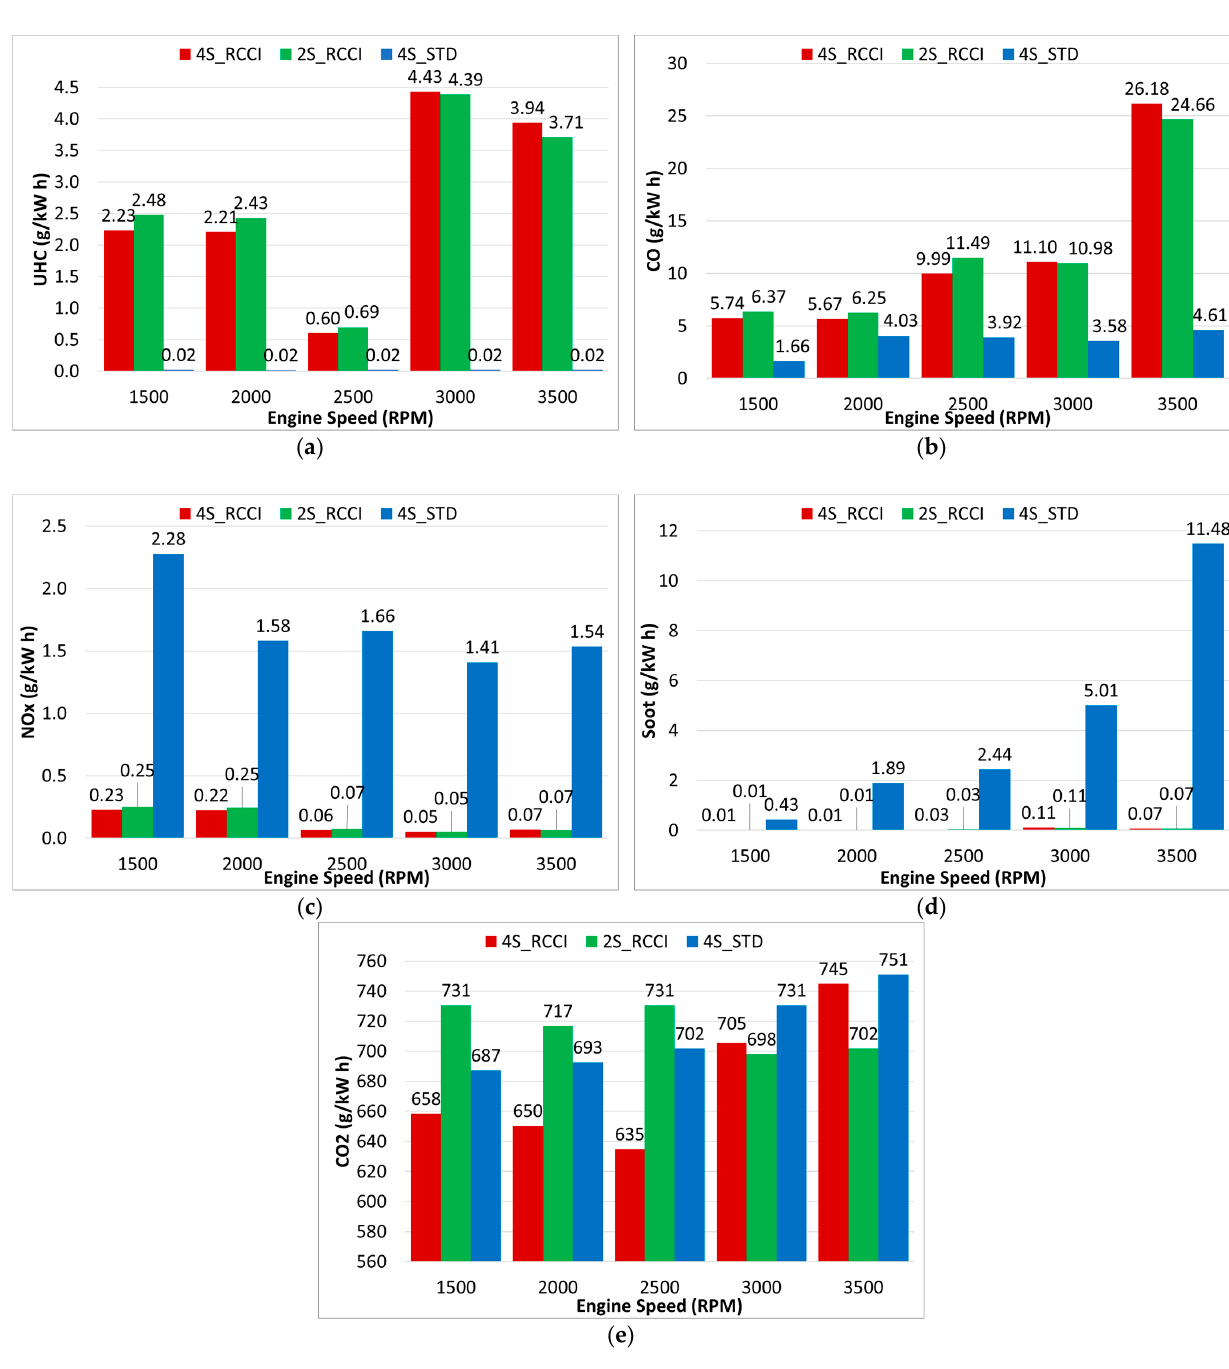
Figure 13. Brake-specific emissions comparison: Specific UHC ( a ), Specific CO ( b ), Specific NO x, ( c ), Specific Soot ( d ), Specific CO 2 ( e )